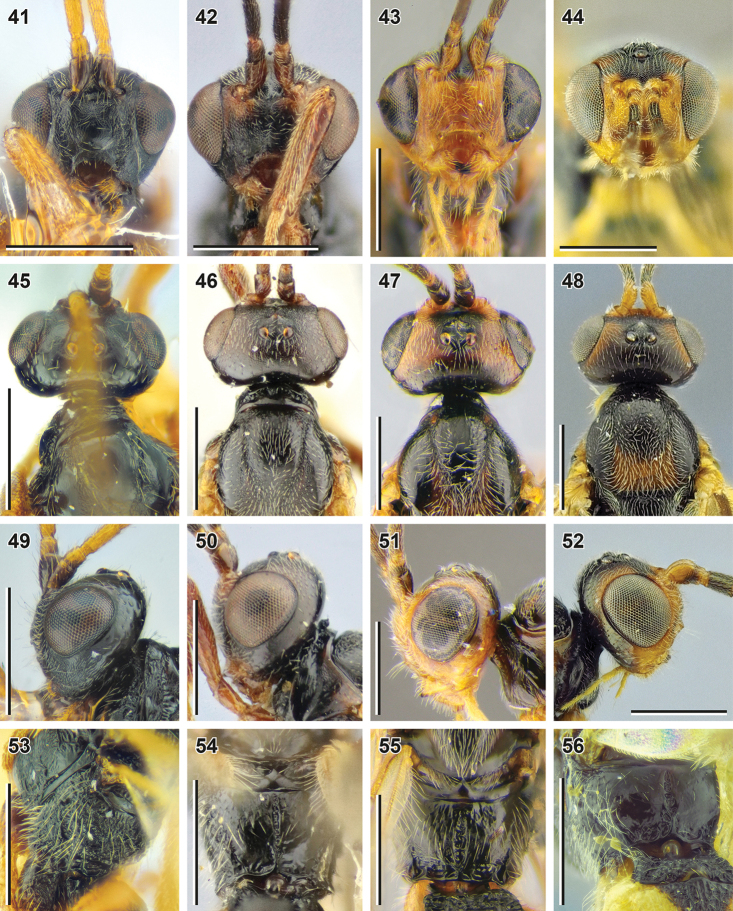
Bracon
sculptithorax Tobias, 2000 (41, 45, 49, 53 holotype, ZISP), B.
kunashiricus Tobias, 2000 (42, 46, 50, 54 holotype, ZISP), B.
sulciferus Tobias, 2000 (43, 47, 51, 55 paratype, ZISP) and B.
acunens Papp, 2018 (44, 48, 52 holotype, HNHM56 female, SMNE) 41–44 head, front view 45–48 head and mesoscutum, dorsal view 49–52 head, lateral view 53–56 propodeum, dorsal view. Scale bars: 0.5 mm.